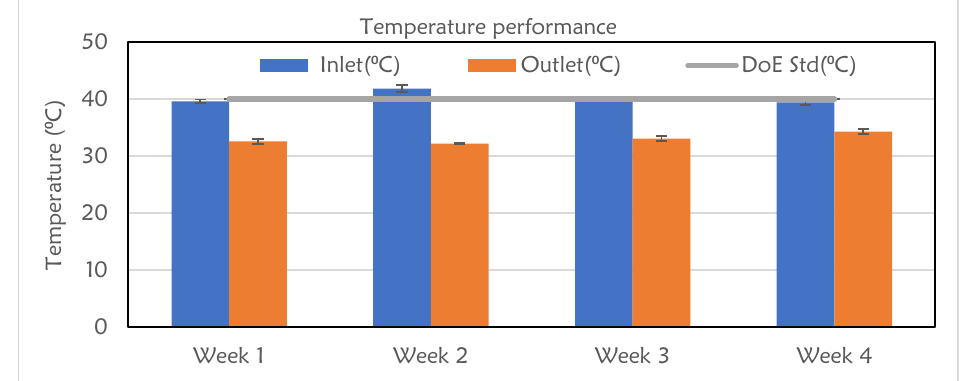
Figure 2: Temperature performance.